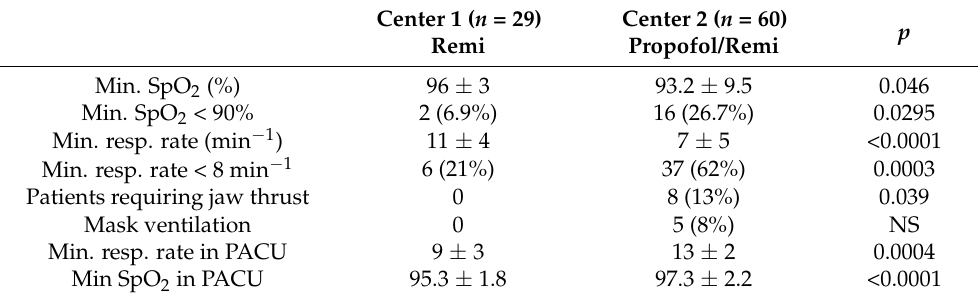
Table 3. Respiratory events during the procedure and